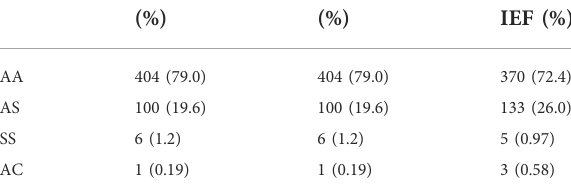
TABLE 3 Showing the frequency distribution of the Hb phenotypes studied in the three methods